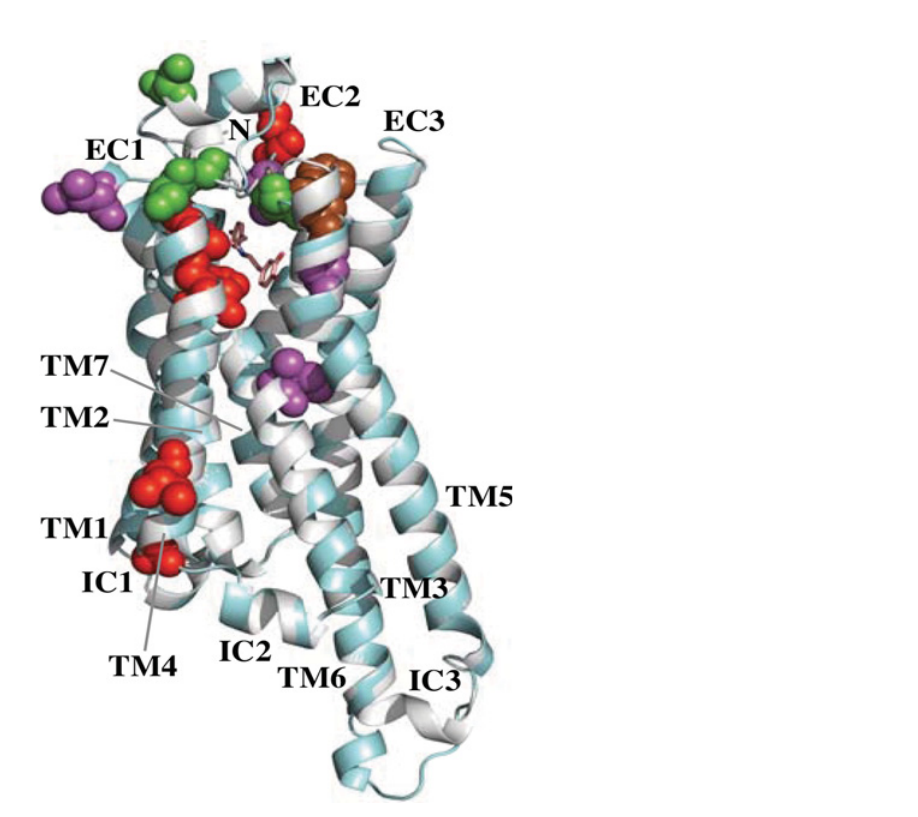
Fig 5. The 3D-structural model of the elephant TAAR7a protein (cyan) superimposed with the turkey β 1-adrenergic receptor ( β 1AR, gray). The ligand of the β 1AR, dobutamine, is shown with the stick model. Positively selected sites are indicated by red (detected by the site model in TAAR7), green (detected by the branch-site model in flying fox TAAR7c and elephant TAAR7a), purple (detected by the site model in TAAR8), and brown (detected by the branch-site model in mouse TAAR8a). The transmembranes (TM) and internal/external loop (IC1-3 and EC1-3) regions as well as N-terminal (N) are labeled. The C-terminal is invisible locating behind TM1. See S6 Fig for more